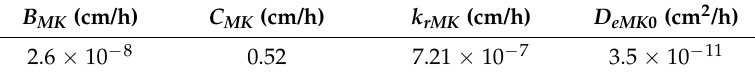
Table 2. Coefficients of the metakaolin (MK) reaction model.